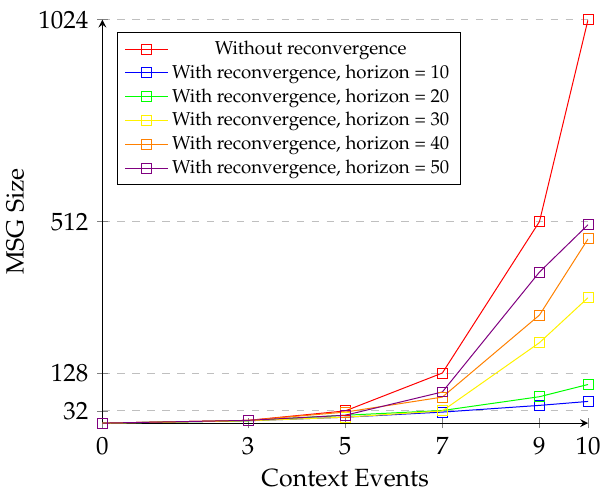
Figure 7. MSG with reconvergence for 60 jobs.